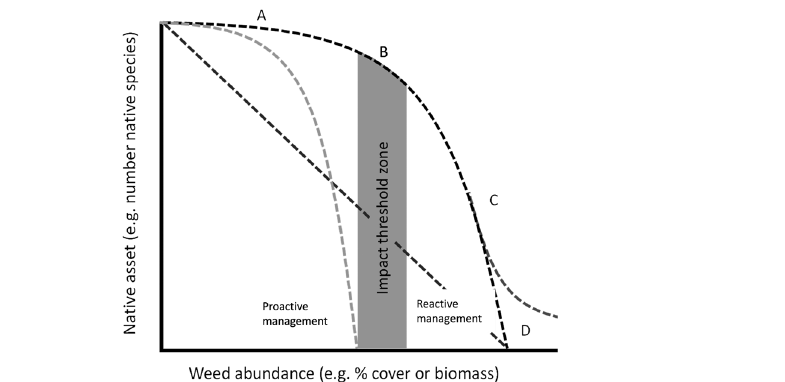
Box 1. Conceptual model for negative impact threshold relationships between invasive plant abundance and a natural asset (e.g. number of native plant species) within the recipient